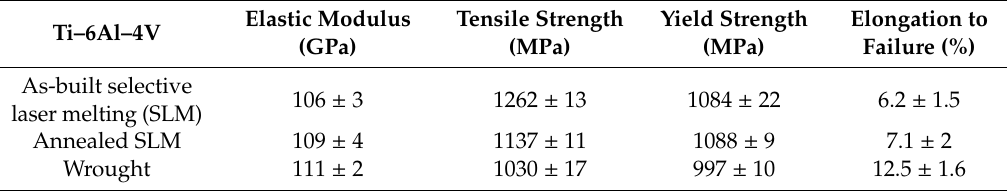
Figure 6. The monotonic stress–strain curves of Ti–6Al–4V. Table 4. Tensile properties of Ti – 6Al – 4V.